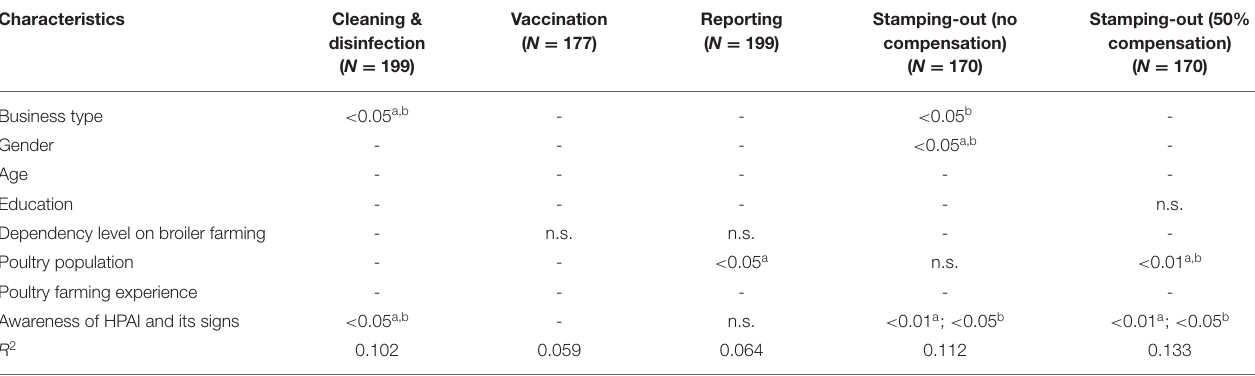
TABLE 3 | Univariable and multivariable logistic regression model results showing significant associations between farm(er) characteristics and each prevention, monitoring, or control measure against HPAI.